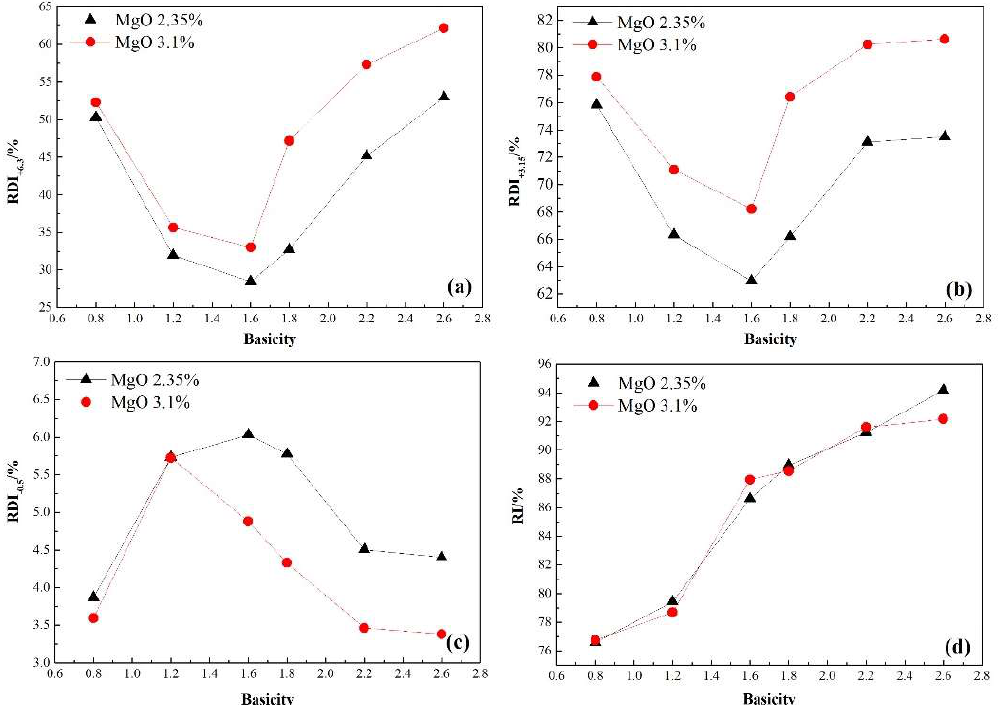
Figure 6. Effect of basicity on the RDI and RI of sinter with different MgO content, ( a )—RDI +6.3 , ( b )—RDI +3.15 , ( c )—RDI -0.5 , ( d )—RI.